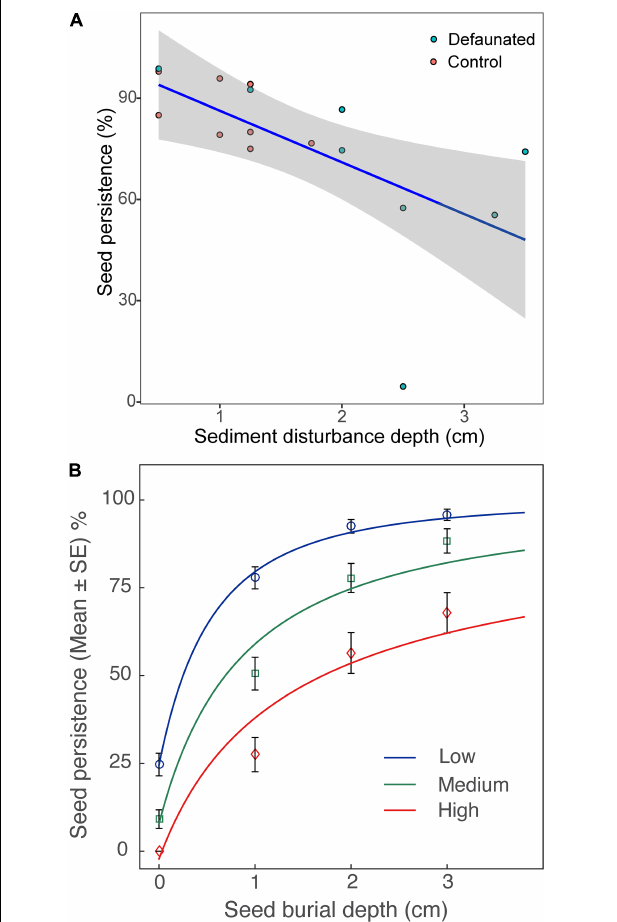
FIGURE 6 | (A) The persistence of the buried seeds decreased with increased sediment disturbance depth (curve fit: y = 1.01 – 0.15x). (B) Effects of sediment disturbance depth (SDD, three levels: low, medium and high) on the persistence of seeds from different burial depths; Low: SDD < = 1 cm, Medium: 1 < SDD < = 2 cm, and High: SDD > 2 cm; the response curves were fit with function: y = 1 − (x + a) ˆ b (Zhu et al.,